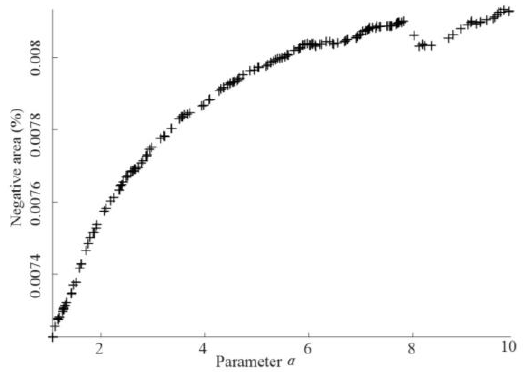
Figure 5 . comparison the use of diffrent 𝛼 .